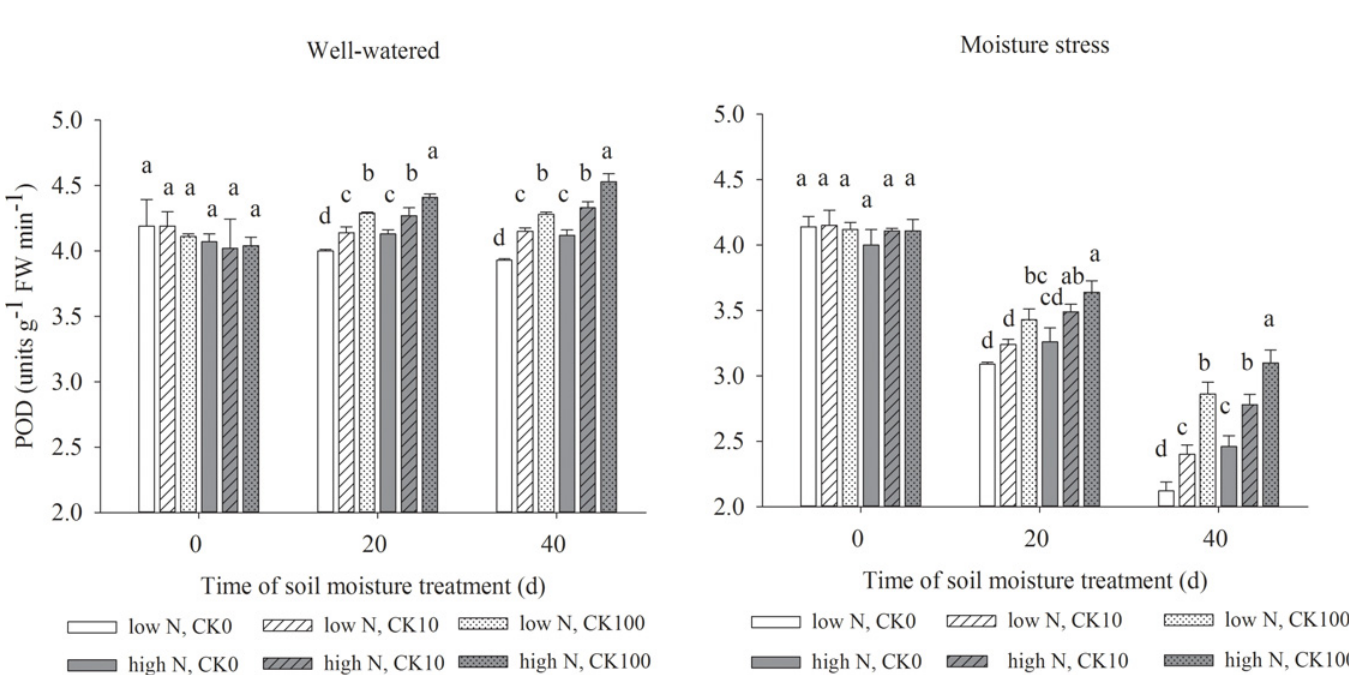
Fig 5. Activities of guaiacol peroxidase (POD) in leaves of drought stressed creeping bentgrass as affected by cytokinin and nitrogen. Bars having different letter indicate no significant enzyme activity difference (P < 0.05) between treatments on the same day.